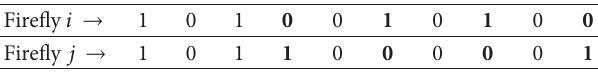
Table 2: Codes for firefly 𝑖 and firefly 𝑗